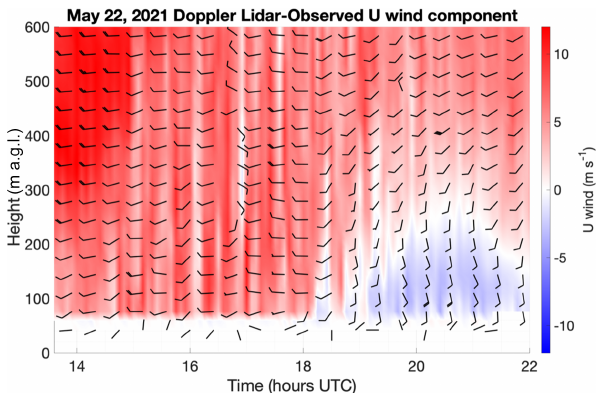
Figure 12. Time–height cross section of the u (zonal) component of the Doppler-lidar-observed horizontal winds (in ms − 1 ), overlaid with horizontal wind barbs (in knots) plotted according to the stan- dard convention from 22 May 2021. Wind barbs are thinned by a factor of 5 in the time dimension and a factor of 2 in the height dimension to aid